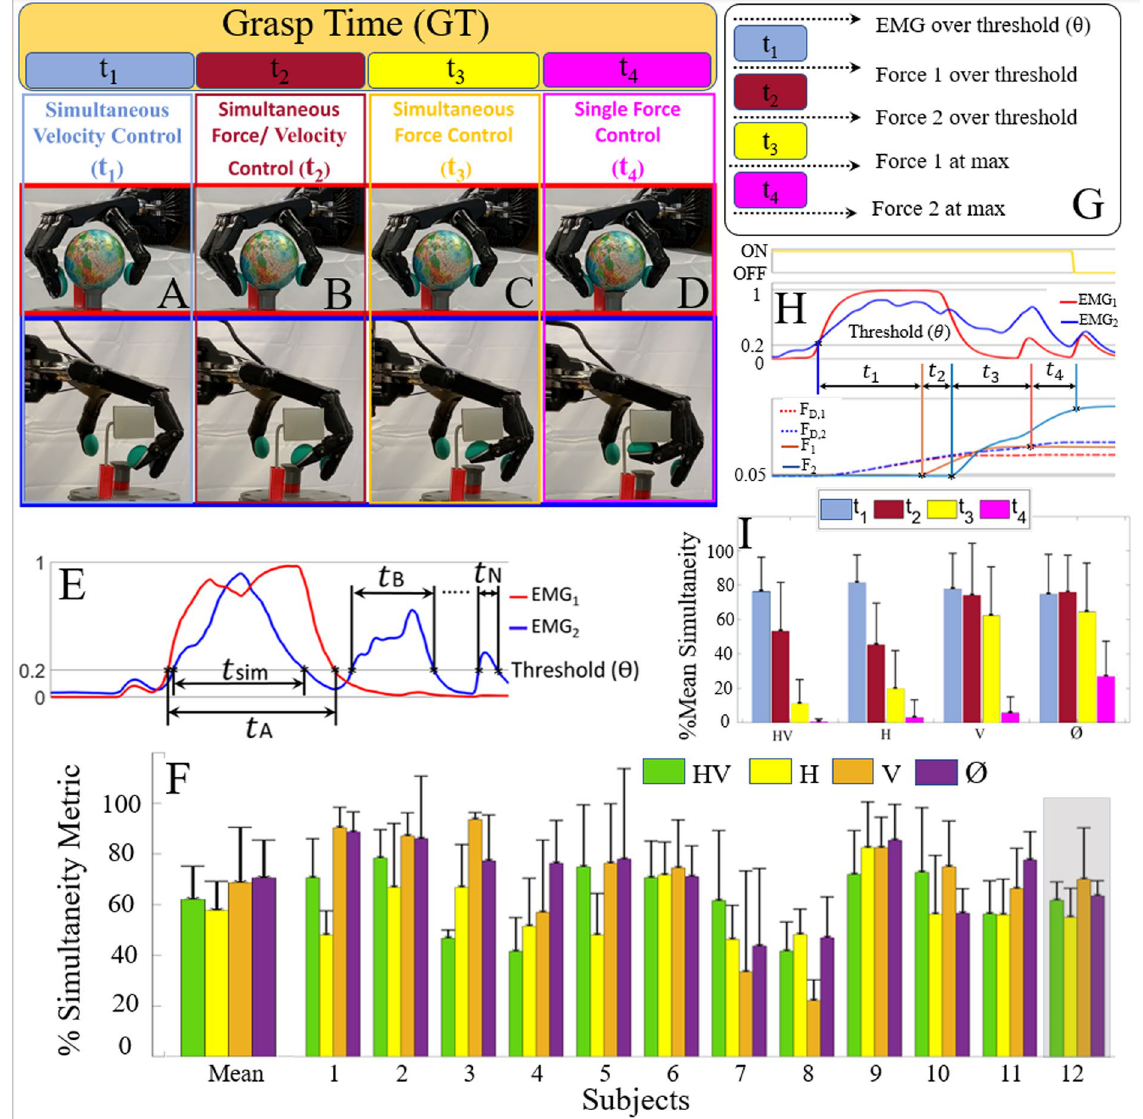
Figure 4. ( A–D ) Comparison of the simultaneity metric under the four time windows: t 1 , t 2 , t 3 , and t 4 . ( E ) Illustrative data showing instances where both grip forces were simultaneously or individually controlled for fine grip force adjustments during the grasp phase of the experiments, prior to transportation. ( F ) Percentage of time that both grip forces were simultaneously controlled by all 12 subjects during the entire grasp phase. The gray highlight indicates the limb-absent subject 12. ( G ) Table and ( H ) sample data of efferent and afferent events that separate the four key time periods during the simultaneous control task. ( I ) Overall averages of all 12 subjects during timeframes t 1 –t 4 with a comparison of the simultaneity metric under the four possible combinations of independent variables: {1} both haptic and visual feedback (HV), {2} only haptic feedback (H), {3} only visual feedback (V), and {4} neither haptic nor visual feedback ( ϕ